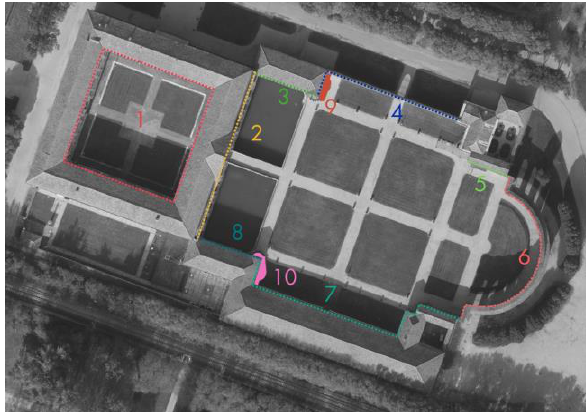
Figure 4. Lot’s scheme: 1Courtyard of honor; 2 East façade; 3